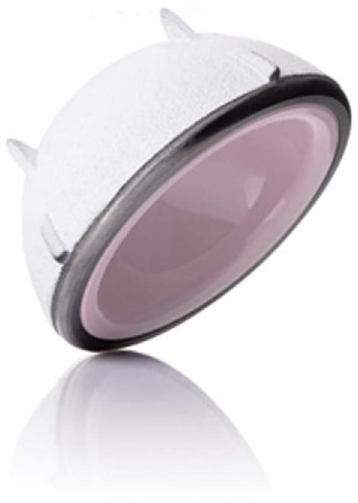
Figure 1. Ceramic-on-ceramic acetabular cup (CARGOS ™ HAP Press Fit cup) with equatorial fi ns and tropical